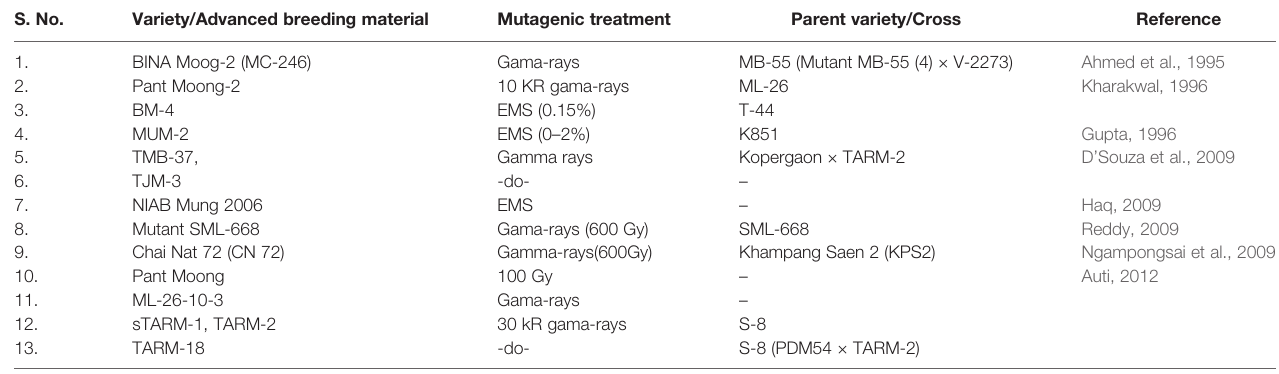
TABLE 4 | List of YMD resistant mungbean varieties/advanced breeding lines developed through the mutagenesis approach. S. No.